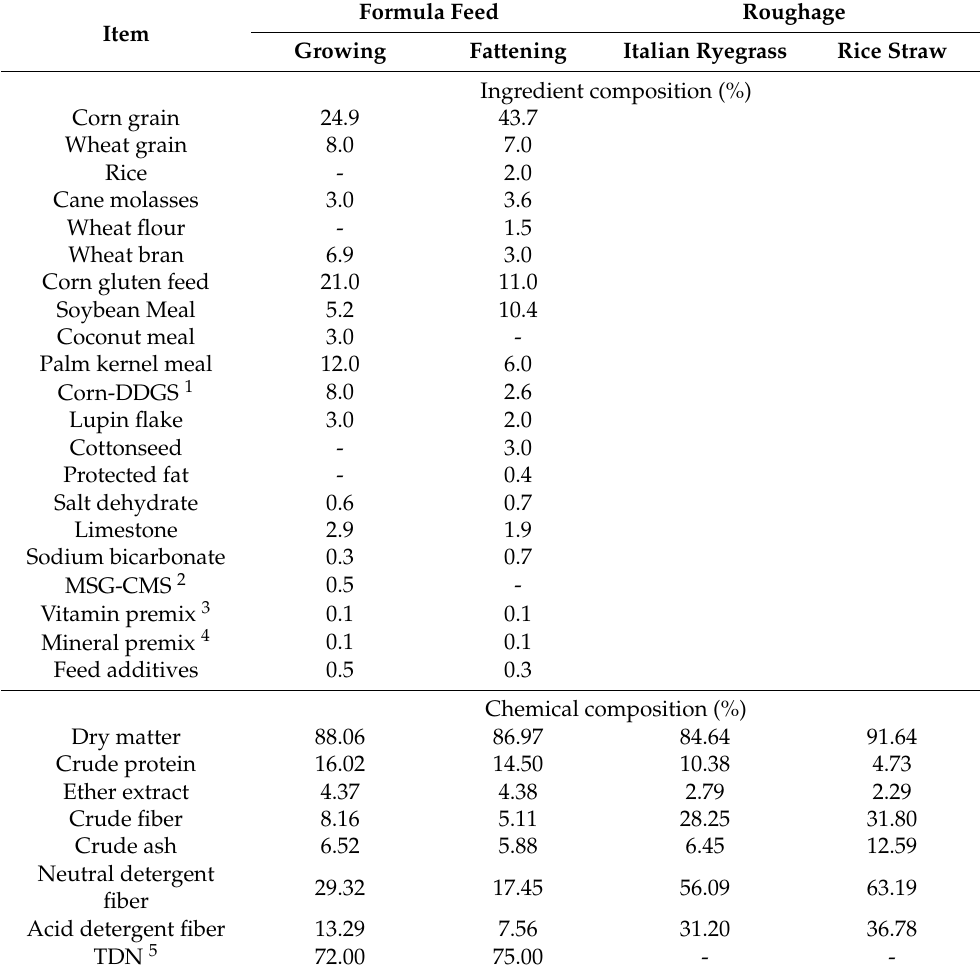
Table 1. Ingredient and chemical composition of the experimental